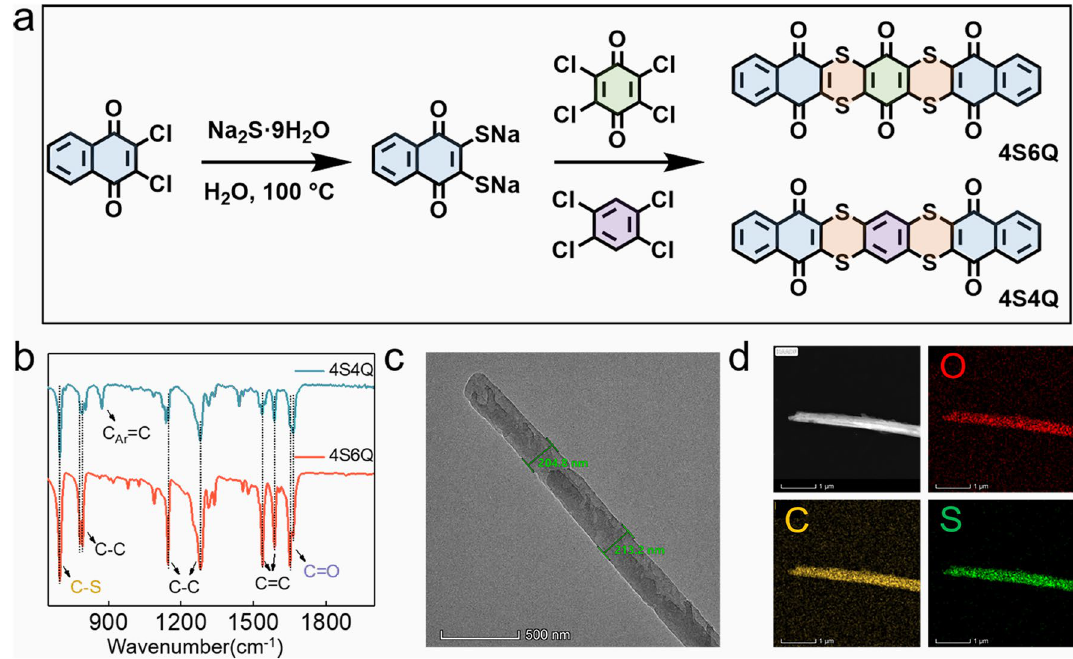
Fig. 1 Synthesis and characterizations. a The synthesis processes of 4S4Q and 4S6Q compounds. b FTIR spectra of 4S4Q and 4S6Q com- pounds. c TEM image of 4S6Q sample. d The TEM-mapping images of 4S6Q